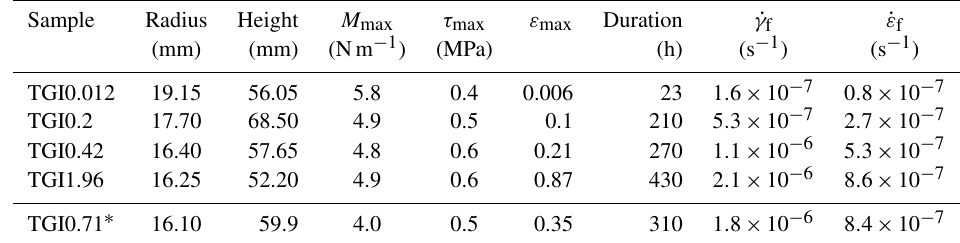
Table 1. Torsion experiment details for each sample. The sample that was annealed is indicated with an asterisk. M max is the calculated torque, τ max is the maximum calculated shear stress, ε max is the maximum measured strain, and ˙ γ f and ˙ ε f are the final measures shear strain rate and strain rate. Sample Radius Height M max τ max ε max Duration ˙ γ f ˙ ε f (mm) (mm) (Nm − 1 ) (MPa)